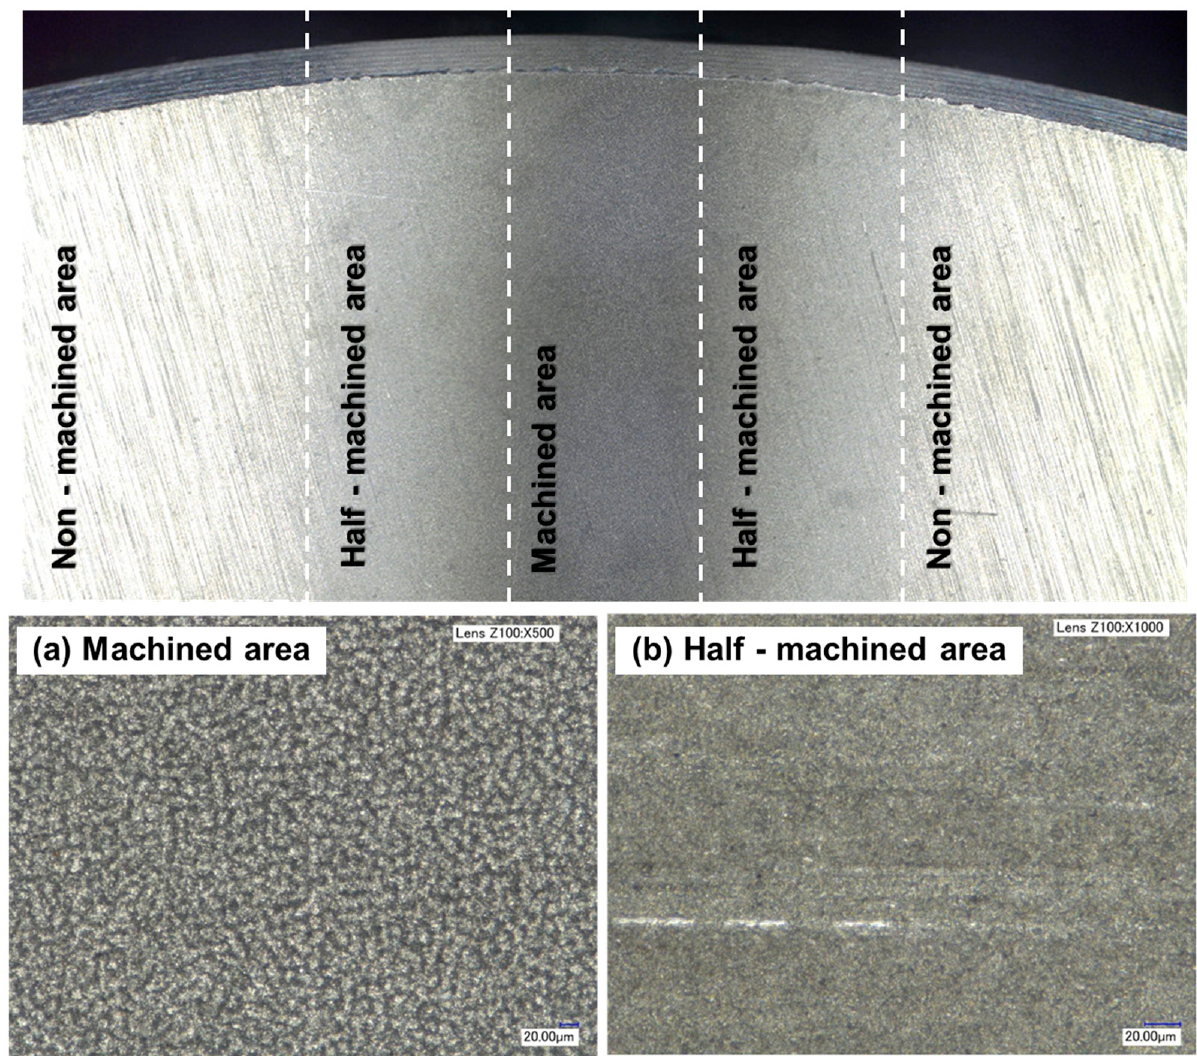
Figure 5. Optical microscopic images of the surface texture.